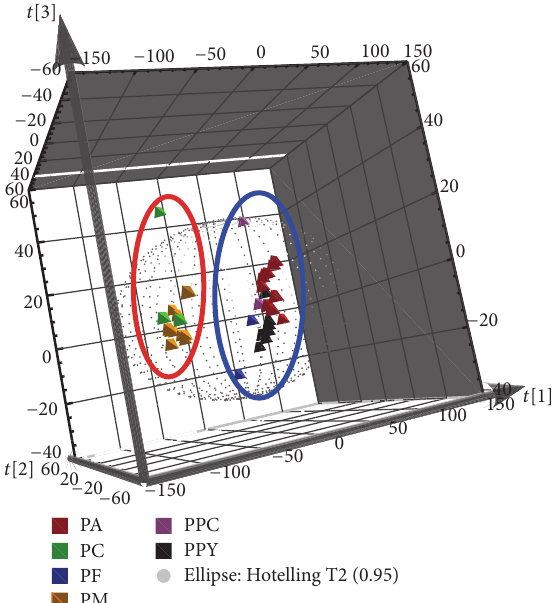
Figure 4: Three-dimensional score plot of principal component analysis for UHPLC fingerprint.